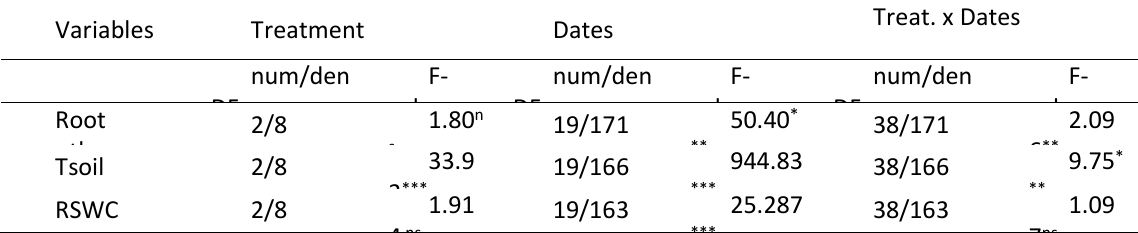
Table S3 . Repeated measure ANOVA is shown for root growth (g m -2 day -1 ), soil temperature (Tsoil, °C) and relative soil water content (RSWC) responses to treatment, dates (d1 to d20) and